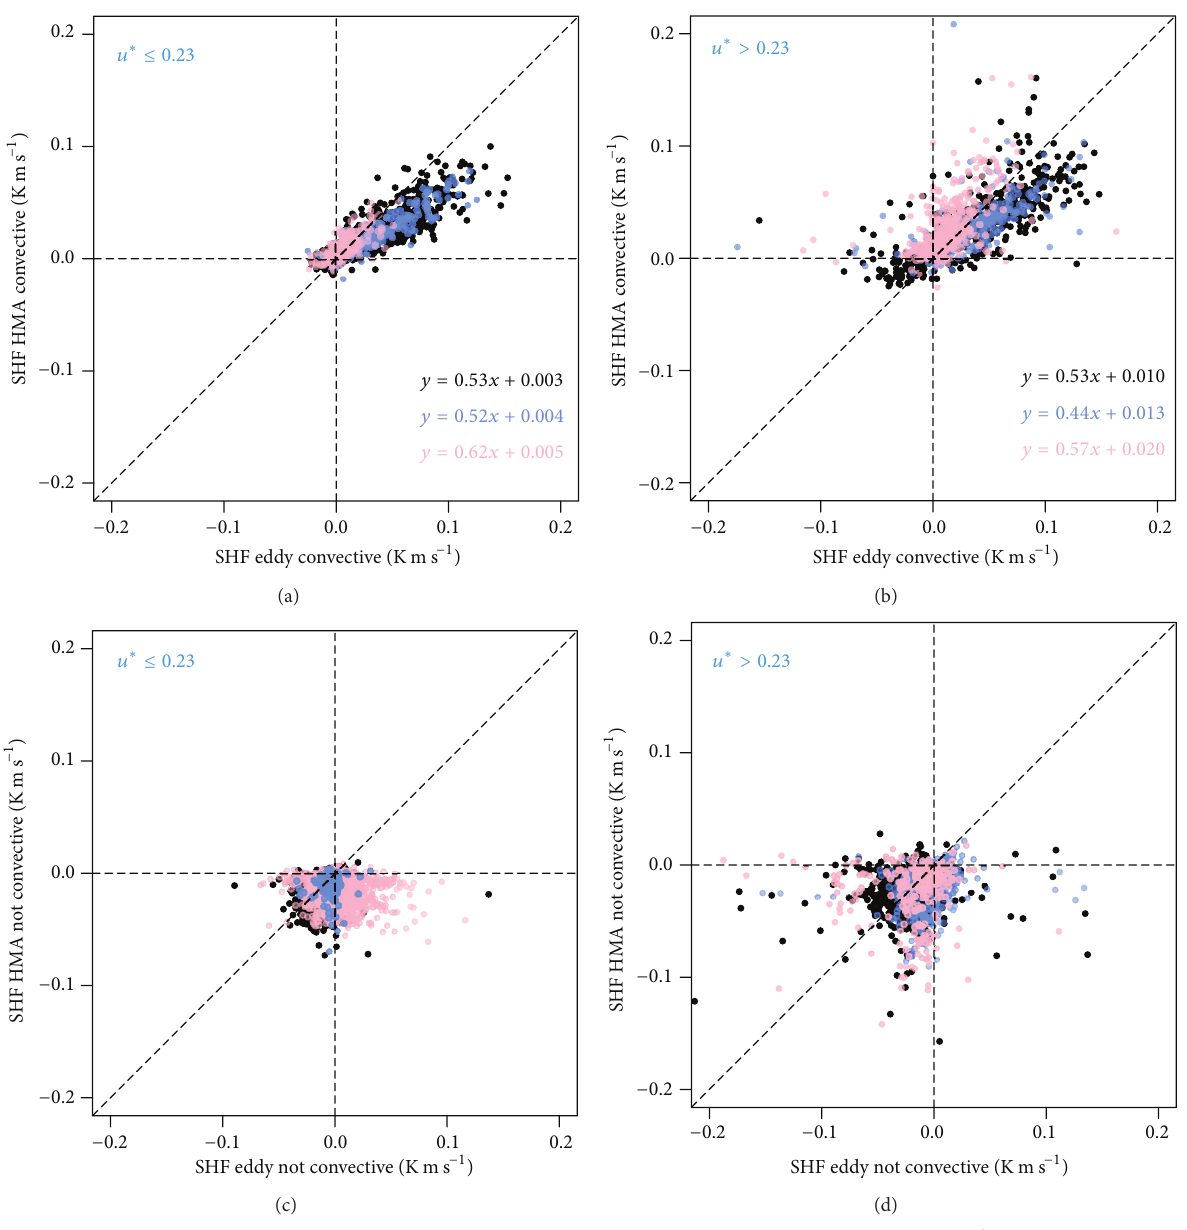
Figure 5: Kinematic sensible heat flux eddy covariance versus sensible heat flux HMA (30min averages, Kms −1 ), separated for the three wind sectors “normal” (20 ∘ –150 ∘ , marked with black dots), “disturbed” (150 ∘ –270 ∘ , marked with pink dots), and “synchronisation” (270 ∘ –20 ∘ , marked with blue dots). Additionally shown are the linear regression equations for the different sectors (colour-coded) for data from the convective period: (a) for the time window 16.6. to 31.8. and friction velocities ≤ 0.23 ms −1 , (b) for the time window 16.6. to 31.8. and friction velocities > 0.23 m s −1 , (c) for the time window 1.9. to 15.6. and friction velocities ≤ 0.23 m s −1 , and (d) for the time window 1.9. to 15.6. and friction velocities > 0.23 m s −1